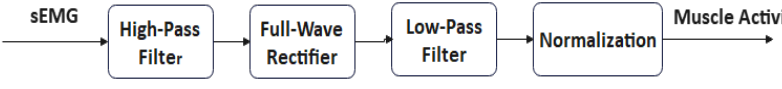
Figure 3. Preprocessing flow chart.